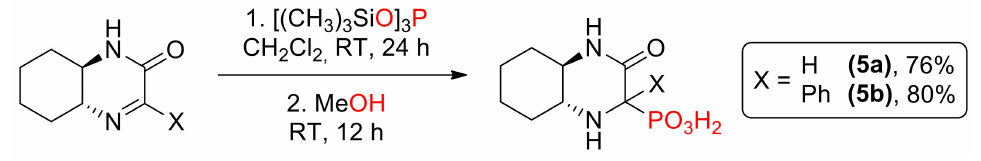
Scheme 4. Synthesis of aminophosphonic acids 5a and 5b .